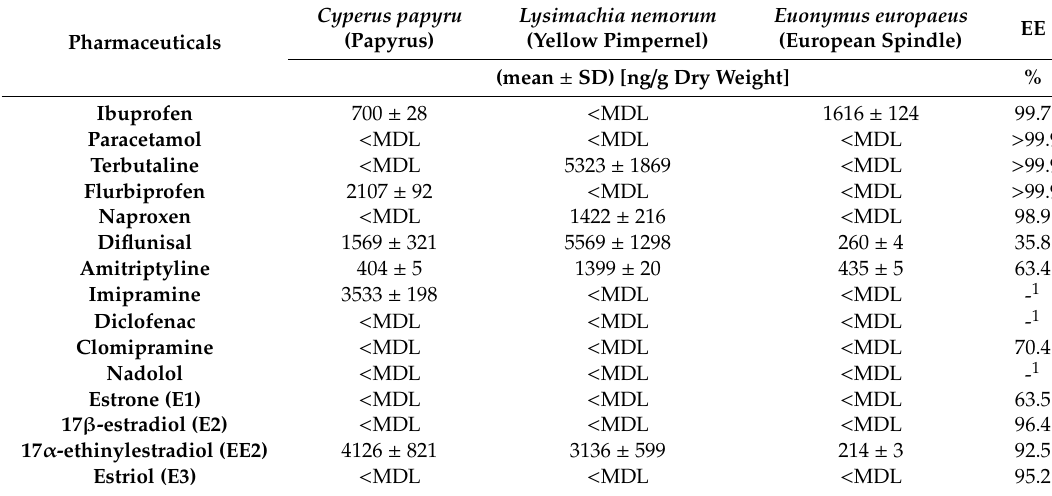
Table 4. Results of determining target compounds in three species of hydroponically cultivated plants from an MWWTP using the developed ASE-SPE-GC-MS(SIM) method ( n = 3), and the elimination e ffi ciency of these compounds from wastewater in an MWWTP supported by constructed